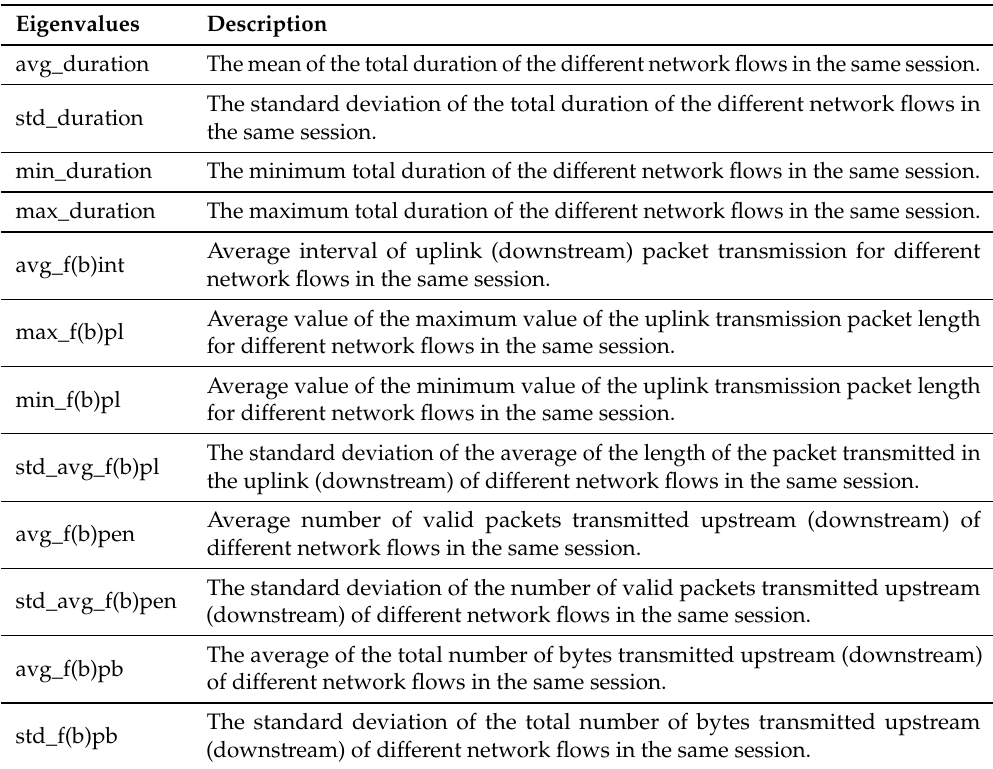
Table 2. Session